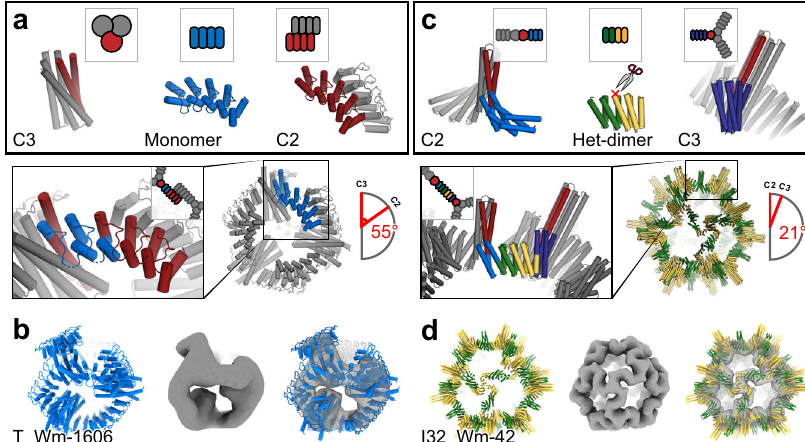
Fig. 5 Design of assemblies with point group symmetry. a Tetrahedron design schematic. A HB and a C2 homo-oligomeric made from ankyrin repeat proteins were aligned to their respective tetrahedral symmetry axis (red), and connected via fusion to Ankyrin repeat monomers (blue) to generate the target architecture. b 3D reconstruction reveals a well fi tting map of T_Wm-1606. c Icosahedral design schematic. Libraries of unveri fi ed cyclic fusion homo-dimers and trimers were aligned to the corresponding icosahedral symmetry axes. Using WORMS, fusions to DHRs split in the center that hold the two homo-oligomers in the orientations which generate icosahedral structures were identi fi ed. d Cryo-EM 3D reconstruction of I32_Wm-42 closely matches the designed